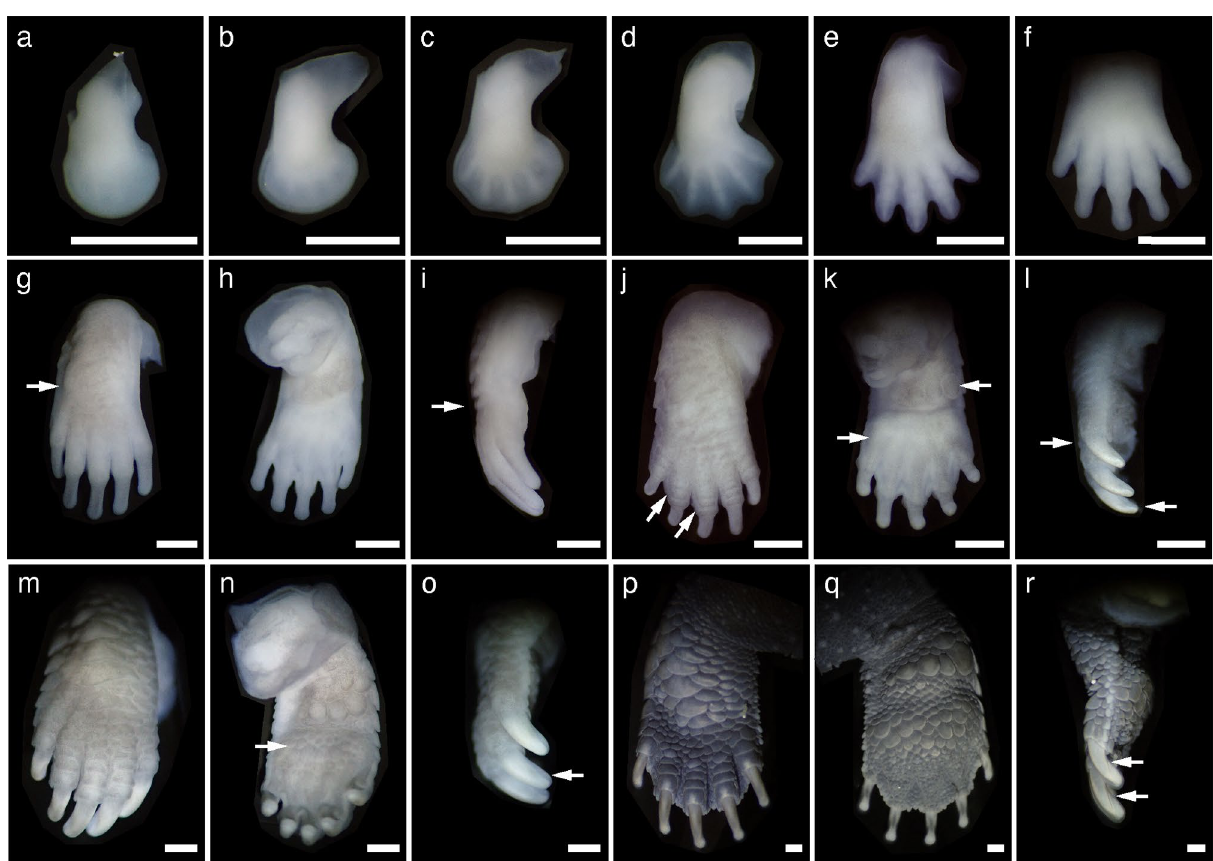
Figure 4. The right forelimb of Mauremys reevesii at stages 15–24, shown in dorsal ( a – g , j , m , p ), ventral ( h , k , n , q ), and lateral view ( i , l , o , r ). ( a ) Stage 15. ( b ) Stage 16. ( c ) Stage 17. ( d ) Stage 18. ( e ) Stage 19. ( f ) Stage 20. ( g ) Stage 21. The arrow indicates that the scales on the dorsal forelimb do not reach the proximal border of the webbing. ( h ) Stage 21. ( i ) Stage 21. The arrow indicates the scales on the dorsal forelimb in lateral view for clarity. ( j ) Stage 22. Both arrows indicate the scales extend to the distal end of the digits. ( k ) Stage 22. The upper arrow indicates four large circular scales aligned in line. The lower arrow indicates the slight formation of small circular scales on palm. ( l ) Stage 22. The upper arrow indicates the scales on the dorsal forelimb in lateral view for clarity. The lower arrow indicates the tip of the ungual phalanx visible in a translucent sheath. ( m ) Stage 23. ( n ) Stage 23. The arrow indicates the palmar surface of the forelimb is fully covered by small circular scales. ( o ) Stage 23. The arrow indicates the ungual phalanx evident in a translucent sheath. ( p,q ) Stage 24. ( r ) Stage 24. The translucent sheath on the ungual phalanx recedes toward its distal end. The scale bar is 1 Stage 16. The optic fissure is evident but becomes narrower, from a “triangular” to “teardrop” shape (Fig. 3d). The anterior end of the mandible extends beyond the level of the center of the eye (Fig. 3d). An incipient tym- panum is barely visible in lateral view. The digital plate has a smooth periphery (Fig. 4b). The carapacial ridge becomes thicker and its anterior edge is distinct in the lateral view (Fig. 2d). The pigmentation becomes denser on the dorsal surface of the neck and head regions and at the base of the tail. Stage 17. The optic fissure is visible but becomes a narrow slit (Fig. 3e). The caruncle is visible as a small white mark on the rostral tip of the upper jaw (Fig. 3e). The mandible extends anteriorly, the ending of which is between the level of the anterior end of the eye and that of the nostril in the lateral view (Fig. 3e). Each of the five digits can be distinguished by a ridge as the digital plate is slightly serrated (Fig. 4c). The posterior border of the plastron is evident (Fig. 5e). A crease on the posterior border of the genital protuberance extends more laterally (Fig. 5e). The urogenital papilla becomes larger and protrudes as it occupies a large proportion of the genital protuberance (Fig. 5e). Ribs can be slightly seen through the carapace in dorsal view (Supplementary Fig. S1e). Stage 18. The optical fissure disappears at this stage, and scleral papillae are evident (Fig. 3f). The caruncle is more evident (Fig. 3f). The mandible and the upper jaw make an almost complete closure as the mandible extends anteriorly beyond the level of the anterior end of the eyes in the lateral view (Fig. 3f). Digits II–IV pro- trude along the periphery of the digital plate but the thickness at the web is greater than the protrusion (Fig. 4d). Carapace pigmentation begins at this stage 18, such that the dorsolateral margins of the carapace are slightly pig- mented, exposing the marginal scutes with faint borders (Supplementary Fig. S1f). The plastron remains unpig-